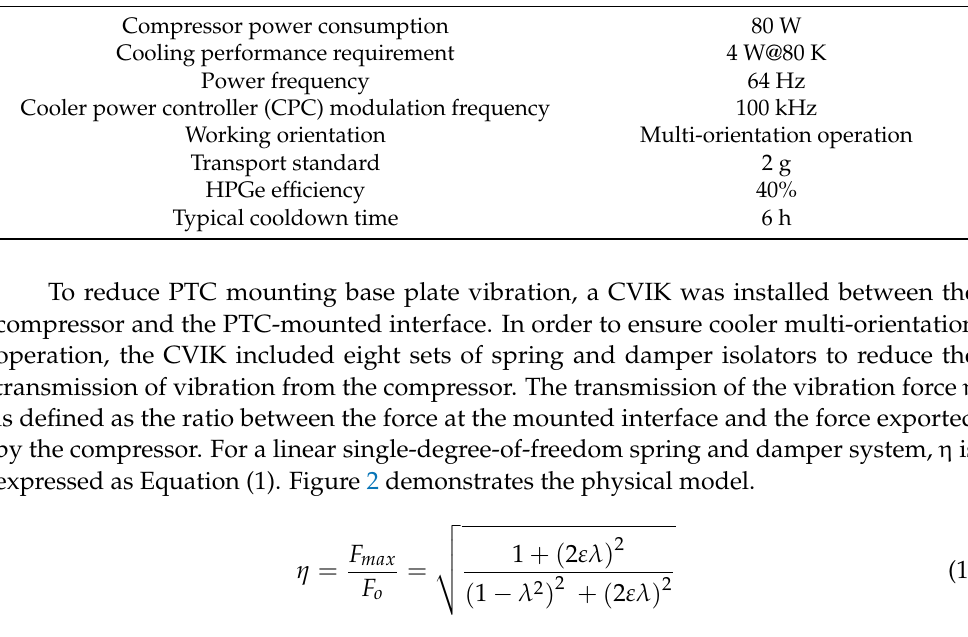
Table 1. The specifications for the low-vibration portable EMC system. Item Specification Compressor power consumption 80 W Cooling performance requirement 4 W@80 K Power frequency 64 Hz Cooler power controller (CPC) modulation frequency 100 kHz Working orientation Multi-orientation operation Transport standard 2 g HPGe efficiency 40% Typical cooldown time 6